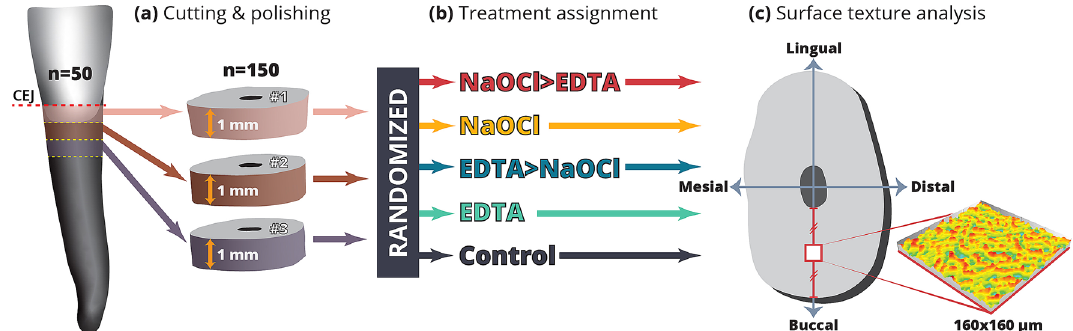
Figure 1. Scheme of the experimental protocol. ( a ) For each tooth (n = 50), three slices, each 1 mm thick, were cut using a low-speed diamond saw (Isomet, Buehler Ltd., Lake Bluff, IL, USA) and ground to achieve a smooth surface using 400-, 600-, 800- and 1200-grit polishing papers. ( b ) A total of 150 dentin slices were randomly assigned to 5 treatment groups (containing 30 slices each). ( c ) For each slice, the midpoint between the pulp chamber and the buccal-most point was identified along the bucco-lingual axis to obtain a 160 × 160 µm surface measurement using a high-resolution confocal disc-scanning measuring system (100 × long distance lens, μsurf explorer, NanoFocus AG, Germany). Subsequently, quantitative 3D surface texture analysis per spot of 160 × 160 µm was conducted using the Mountains Map Premium software (v 7.3.7, DigitalSurf,